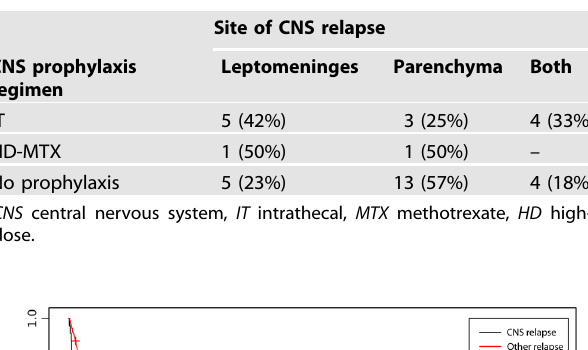
Fig. 2 Cumulative incidence of CNS relapse rate by prophylactic strategy. IT MTX intrathecal methotrexate, HD-MTX high-dose methotrexate.